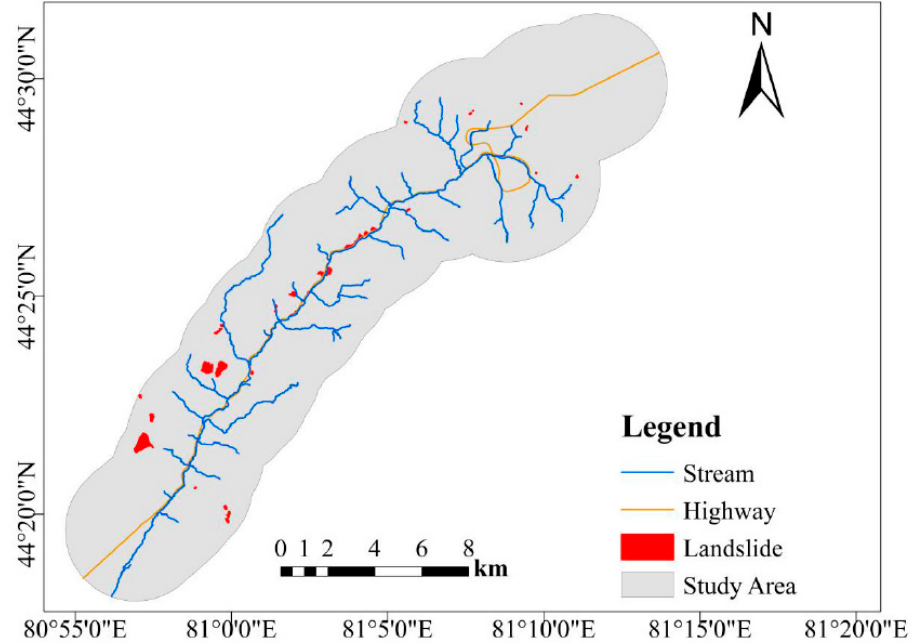
Figure 3. Landslide inventory map for 2020, generated mainly using GF-1 satellite images.